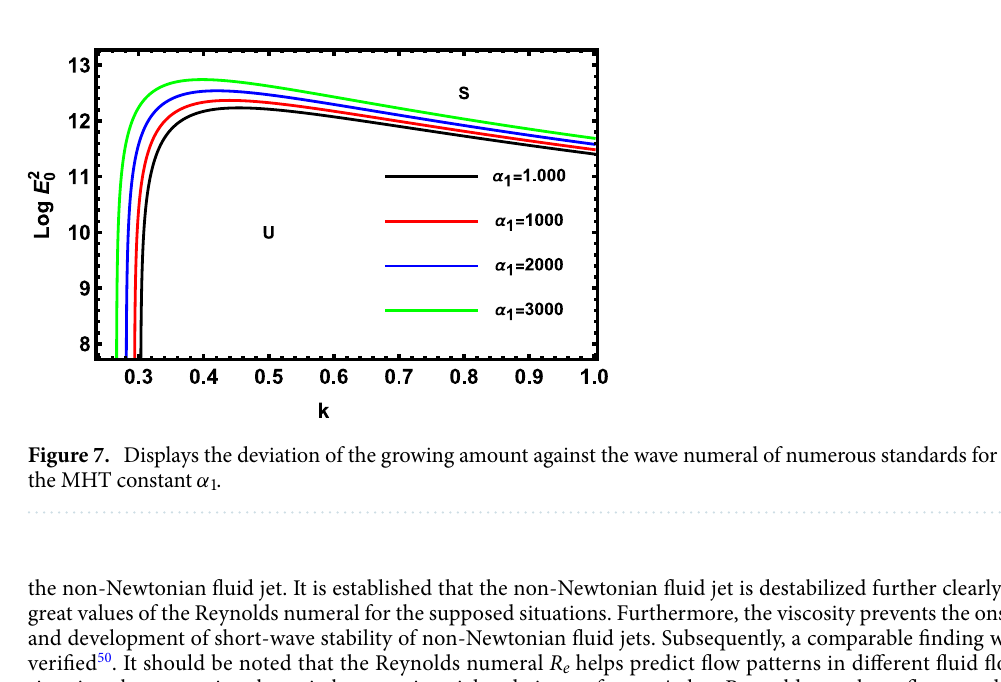
Figure 6. Displays the deviation of the rising amount against the wave numeral of numerous standards for the Elasticity Numeral E l .